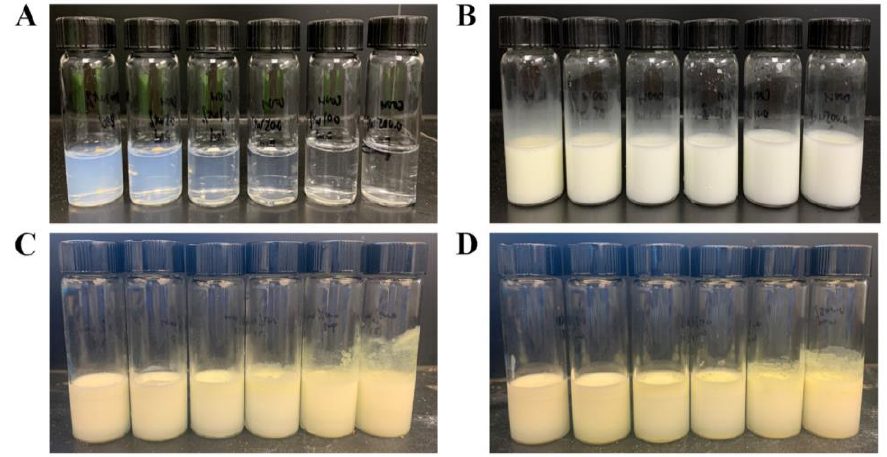
Figure 3. Photographs of ( A ) TEMPO-oxidized chitin nanocrystals (T-ChNCs) suspensions; Emul- sions stabilized by T-ChNCs with different concentrations: ( B ) freshly prepared, ( C ) stored 14 days in the refrigerator, ( D ) stored 14 days at room temperature. Bottles from left to right contained 1.0, 0.5, 0.1, 0.05, 0.01 and 0.005 wt% of T-ChNCs.